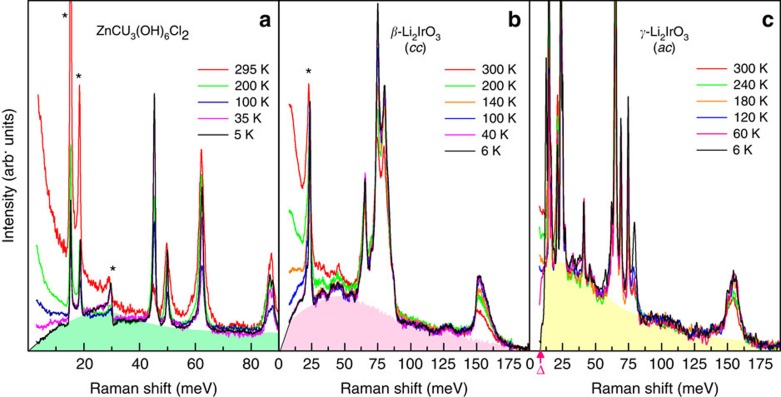
Comparison of the spinon continuum between the kagome and the honeycomb lattices.(a) Raman spectra of ZnCu3(OH)6Cl2 in (aa) polarization as a function of temperature. The data are taken from ref. 43. The shadings are the spinon continuum. The asterisks denote optical phonons with Fano line shape. (b,c) Raman spectra of β- and γ-Li2IrO3 at various temperatures.